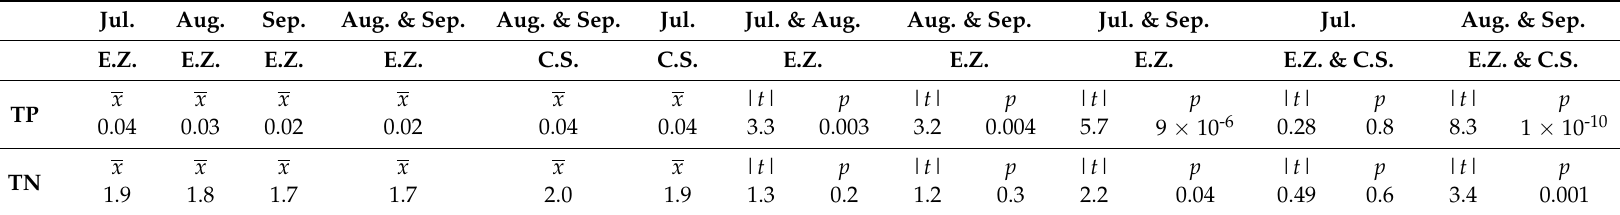
Table 3. Student’s t -test results for TP and TN in water (a =